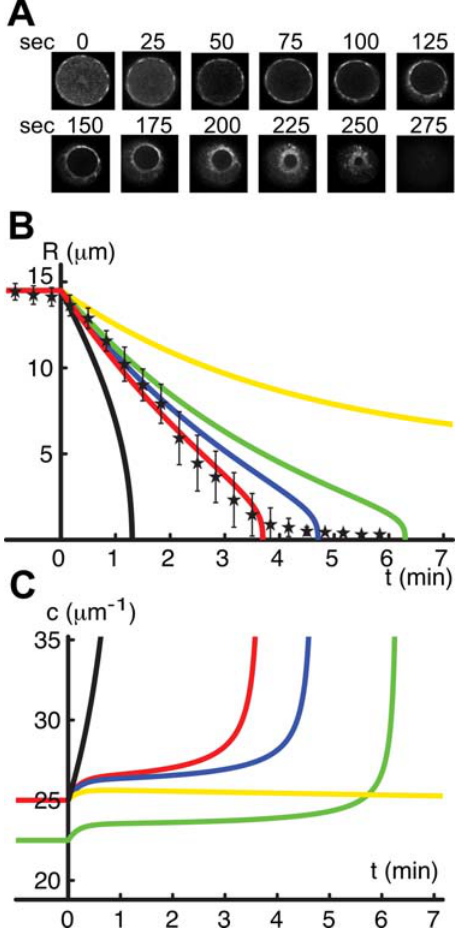
Figure 1. Dynamics of ring contraction. (A) Time lapse images of GFP tagged non-muscle myosin 2 during the first division using end-on imaging of a dividing C. elegans embryo at 21 u C, which show the contracting ring structure. (B) Ring radius as a function of time. Stars indicate the average of eight experimentally observed ring radius traces as shown in (A). Bars mark one standard deviation. The colored lines represent solutions to Eqs. (1)–(4). For sufficiently large rate of filament turnover k d ~ 0 : 1 s (cid:1) 1 , k p ~ 2 : 5 s (cid:1) 1 m m (cid:1) 1 , and using A ~ 1 : 2 | 10 { 3 nN m m 2 , the calculated dynamics corresponds well to the observed one (red line). Reducing the polymerization rate